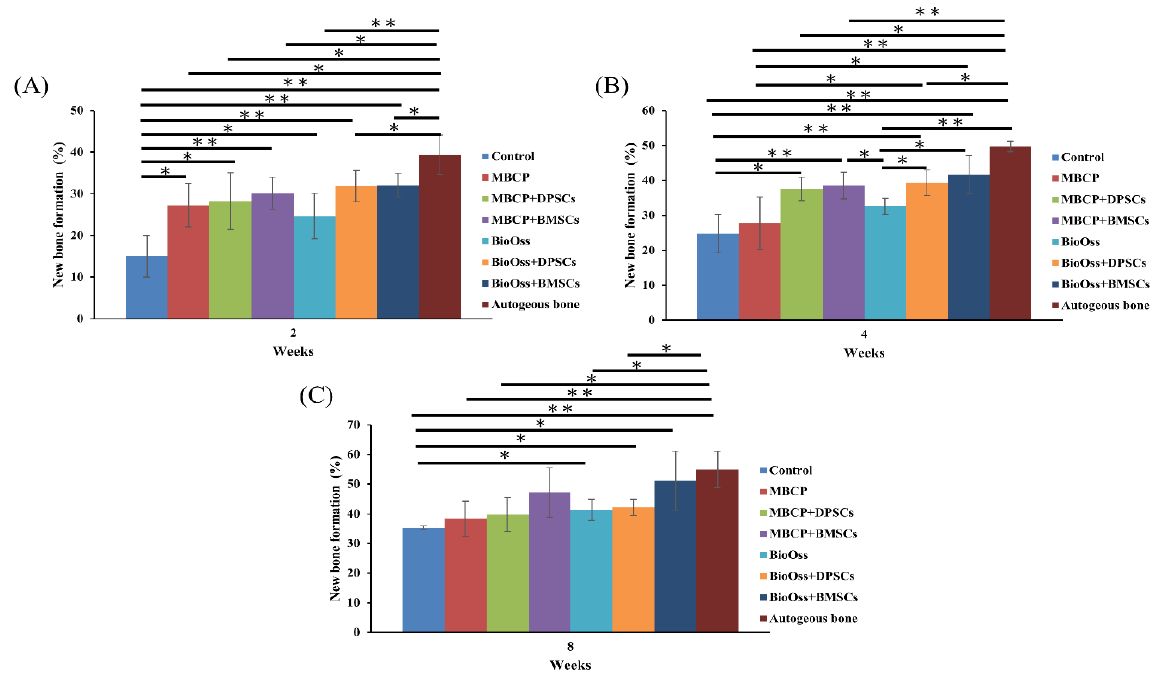
Figure 9. Statistical results of the histomorphometric analysis after 2, 4, and 8 weeks of healing (* p < 0.05 and ** p < 0.01). ( A ) The new bone formation percentages in the autogenous bone group are significantly higher than other groups after 2 weeks of healing. ( B ) The new bone formation percentages of the Bio-Oss+BMSCs and autogenous bone groups were no significantly different after 4 weeks of healing. ( C ) Similar new bone formation percentages were demonstrated among MBCP+BMSCs, Bio-Oss+BMSCs and autogenous bone groups after 8 weeks of healing.